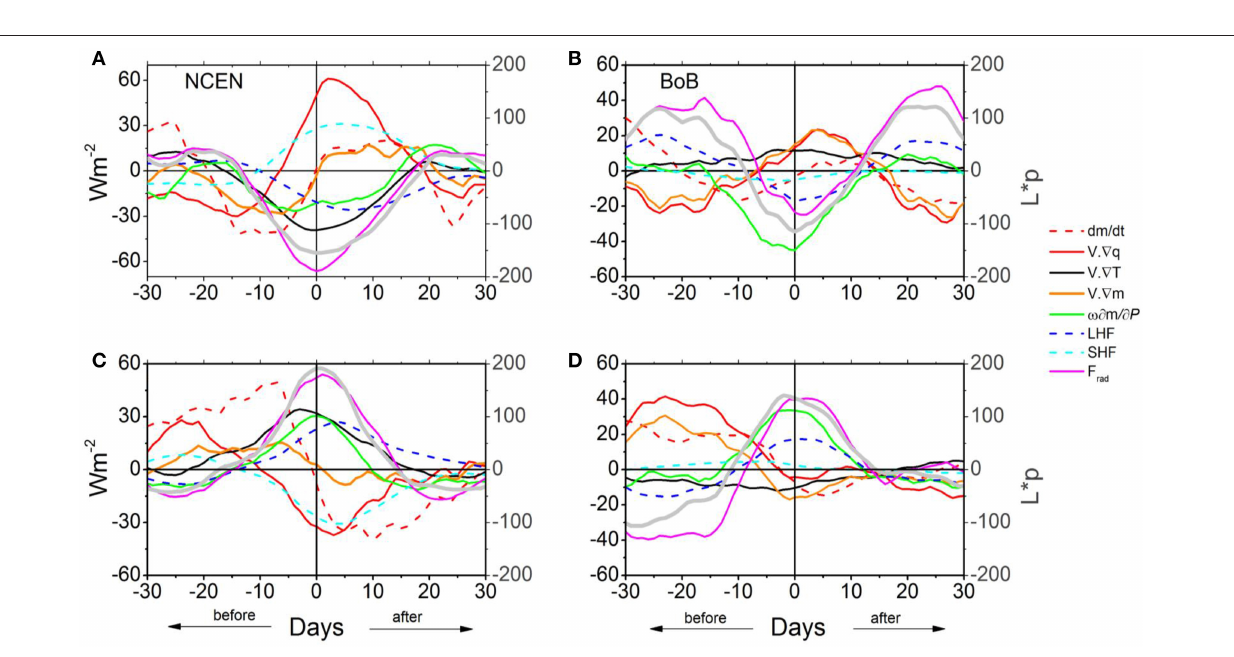
misrepresentations of model temperature and/or advection term (physics and dynamical